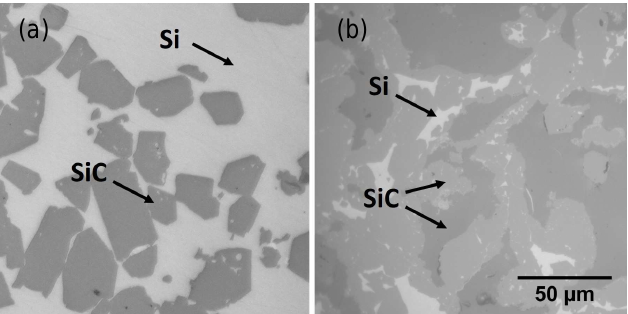
Figure 14. Optical microscopy of the infiltrated Si-SiC ( a ) and phenolic resin impregnated Si-SiC ( b ) materials.